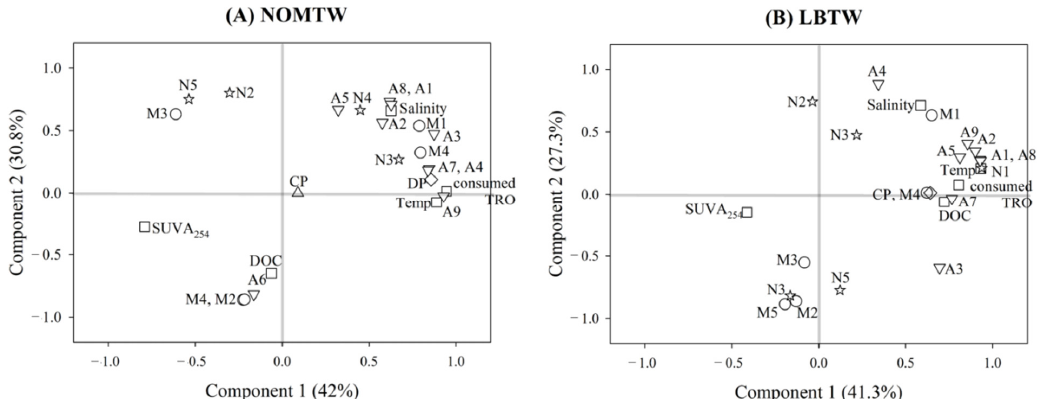
Figure 3. PCA results for ( A ) AOMTW and ( B ) LBTW showing the correlation between the physicochemical parameters and the formation of corresponding disinfection by-products ( n = 9). (□: Environment; ○ : THMs; ▽ : HAAs; ☆ : HANs; △ : HPA; ◇ : HN).